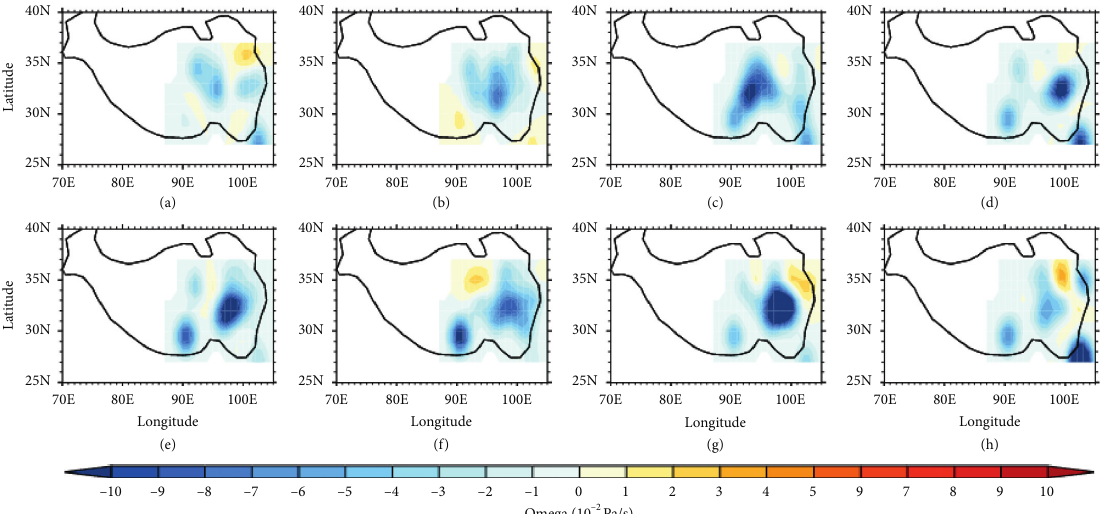
Figure 7: The composite horizontal distributions of vertical velocity (units:10 − 2 Pa/s) on 350K isentropic surface for the (a) 7th day, (b) 6th day, (c) 5th day, (d) 4th day, (e) 3rd day, (f) 2nd day, (g) 1st day, and (h) 0 day before the OCS onset for 41 OCS events.